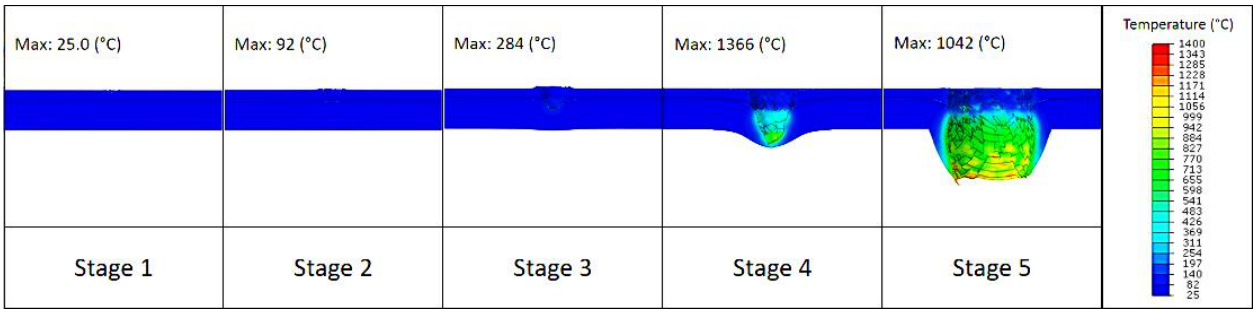
Figure 25. Frictional heat generation for friction drill joining of AISI304/Al6061, at different stages.